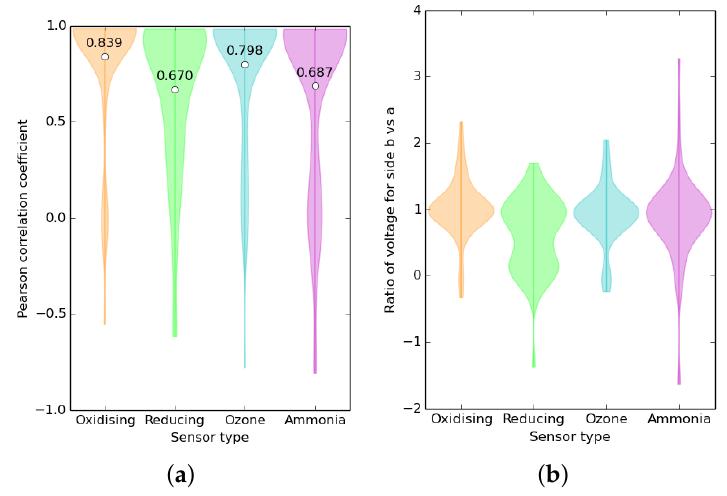
Figure 18. ( a ) Violin plot of Pearson correlation between the a and b sensors. The mean correlation between sensor pairs is marked with a white dot and labelled. ( b ) Violin plot of the distribution function of the gradient of a linear fit of Side a to Side b. This plot essentially shows the distribution of the average ratio of pairs of sensors to each other. The output voltage of the sensor electronics in this experiment is linearly proportional to the element